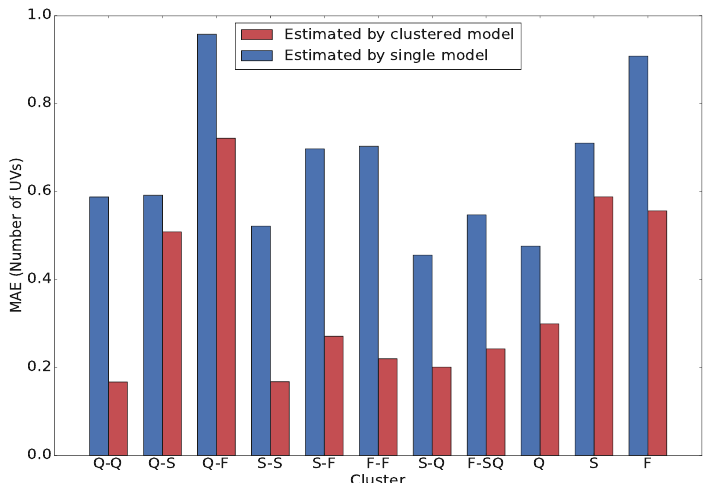
Figure 7. MAE for the cases when a model is built for each cluster and when a unique model is built for all clusters, in the disaggregated approach.